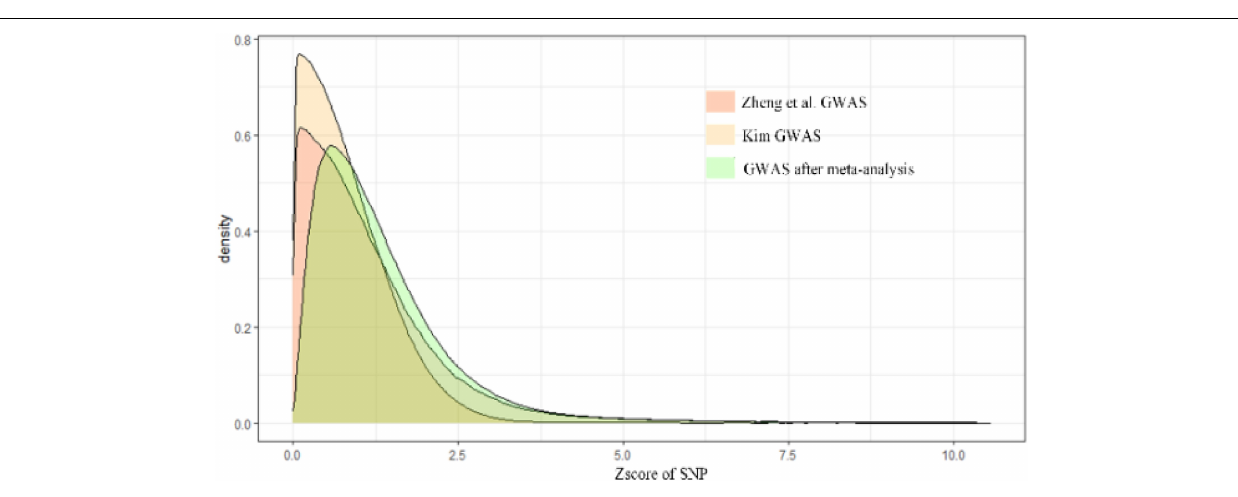
FIGURE 2 | The result of GWAS meta-analysis on